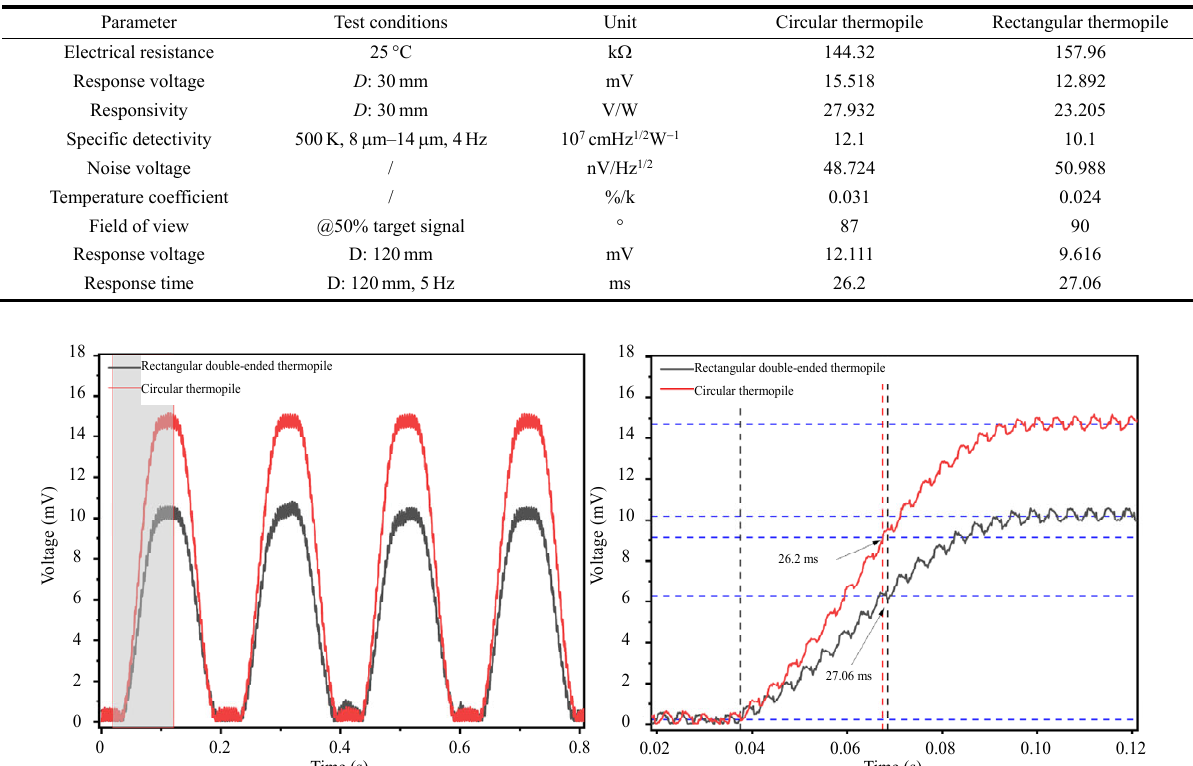
Fig. 10 Infrared test system: (a) infrared test system schematic and (b) infrared test system physical diagram. Table 2 Performance parameters of circular thermopile and double-ended symmetrical rectangular thermopile.